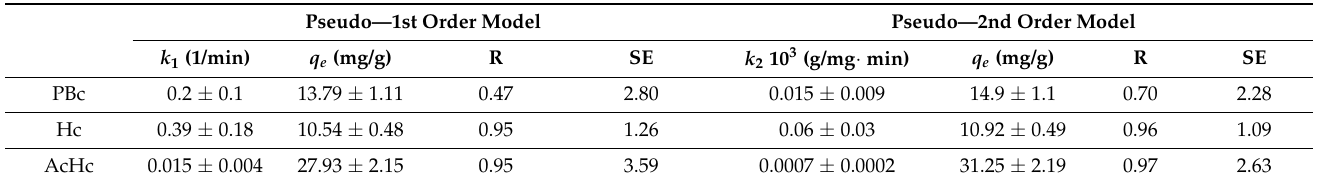
Table 2. Parameters obtained from kinetic model fittings (value ± standard error of the